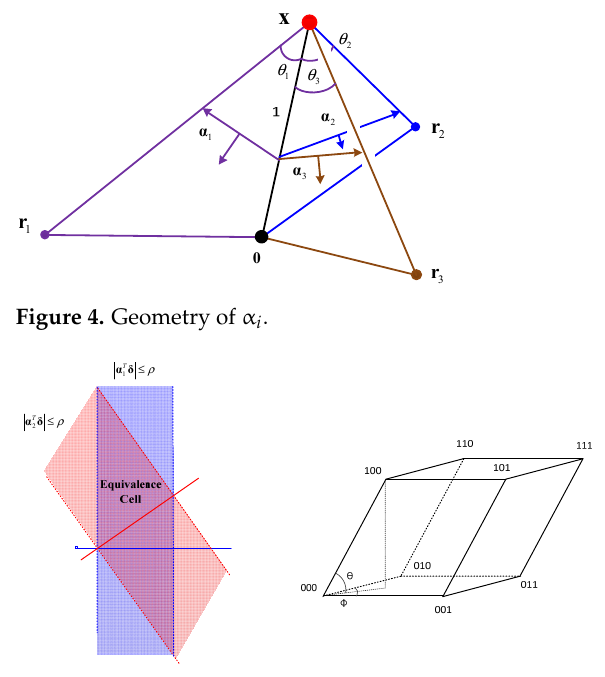
Figure 5. Shape of the equivalence cell with N = 3 .